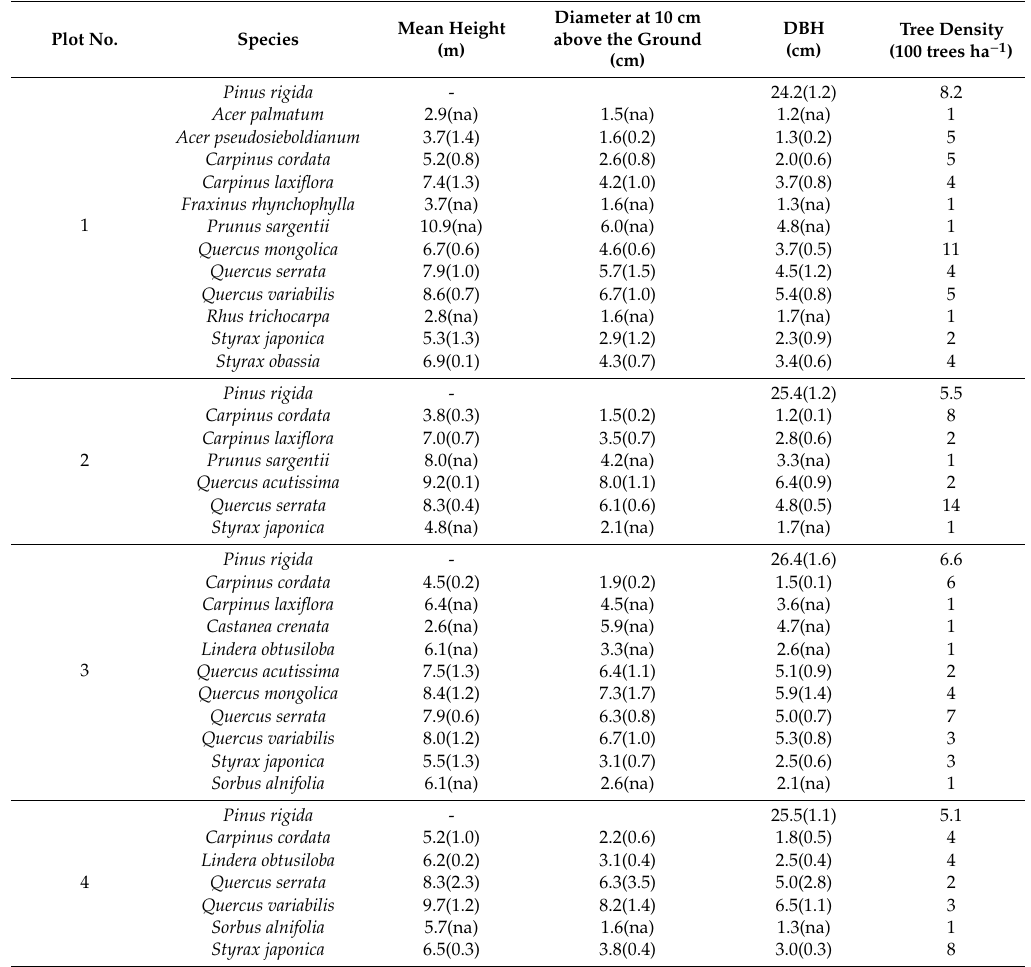
Table 2. Species characteristics of over- and under-story layer in the Pinus rigida plantation. The values of mean diameter at 10 cm height above the ground for all understory trees and DBH (Diameter at Breast Height) for P. rigida and understory trees, respectively. Parentheses denote standard errors. ‘na’ means not available because of one sample